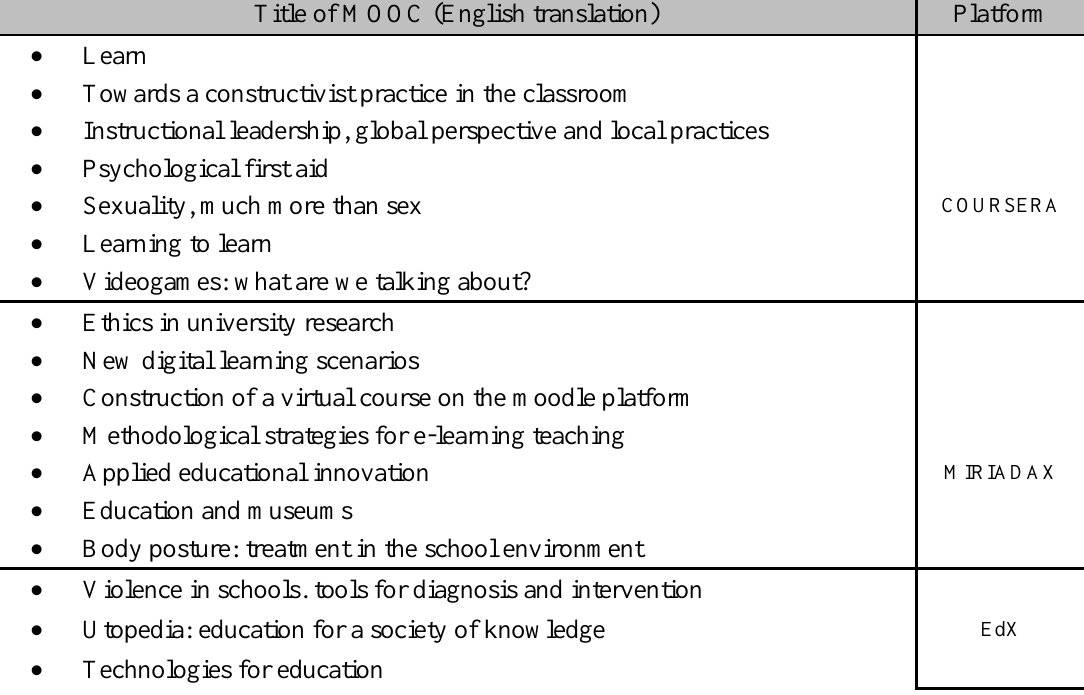
Courses Analysed Title of MOOC (English translation)